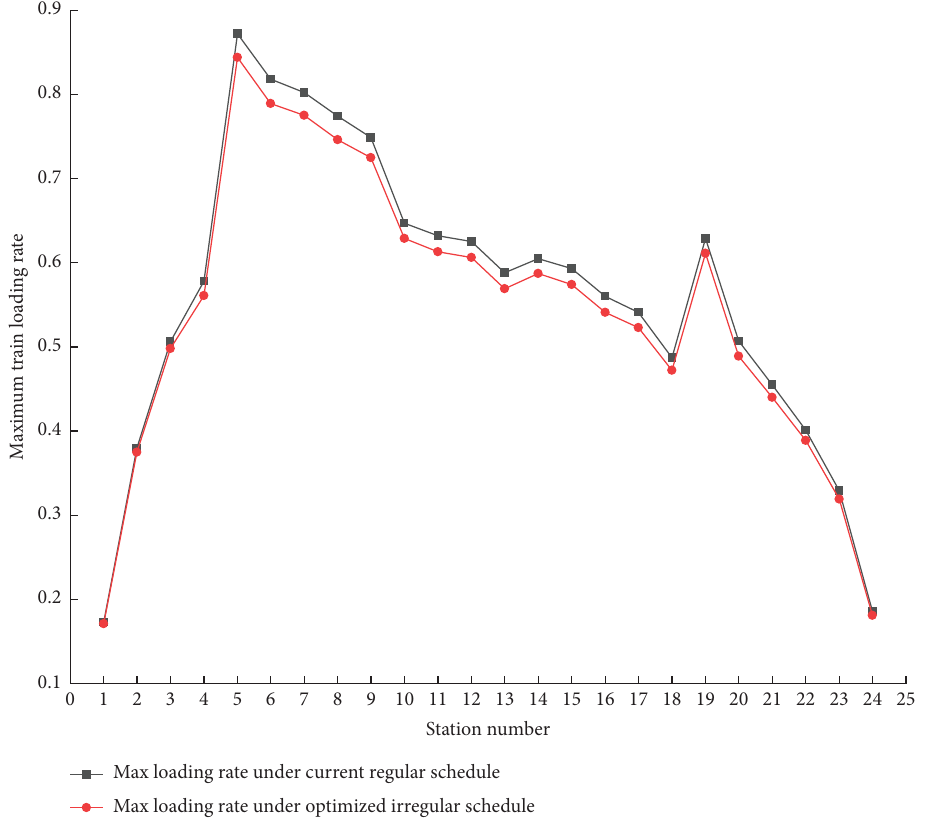
Figure 5: Maximum train loading rate under the optimized irregular schedule and current regular